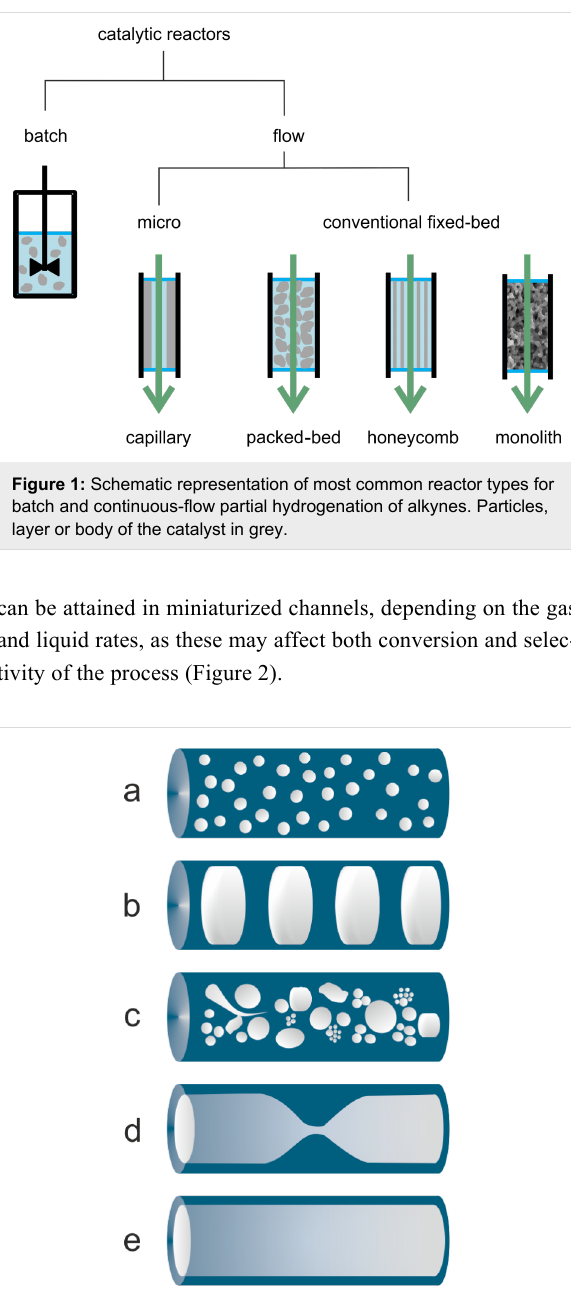
Figure 2: Schematic representation of flow regimes in microchannels; (a) bubbly flow, (b) slug/Taylor or segmented flow, (c) churn flow, (d) slug/annular flow, (e) annular